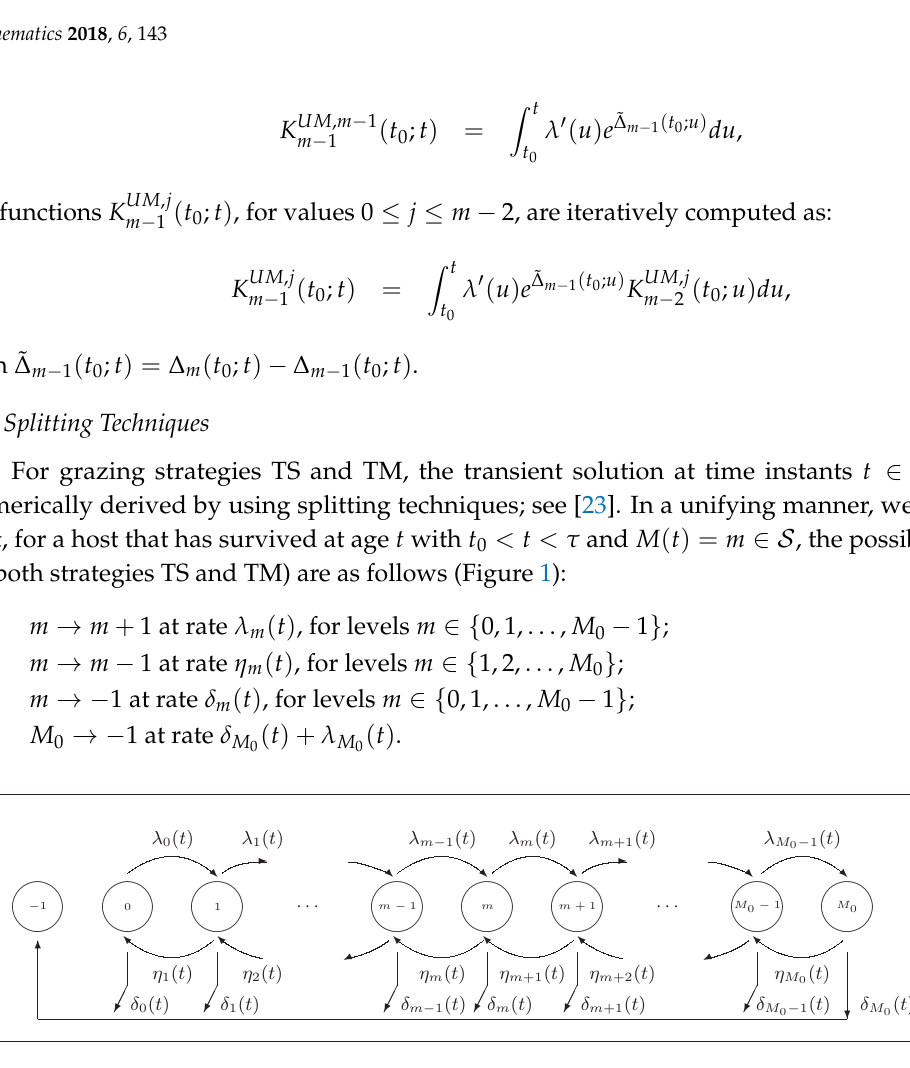
Figure 1. State space and transitions at post-intervention instants t ∈ [ t 0 , τ ] . Grazing strategies TS and